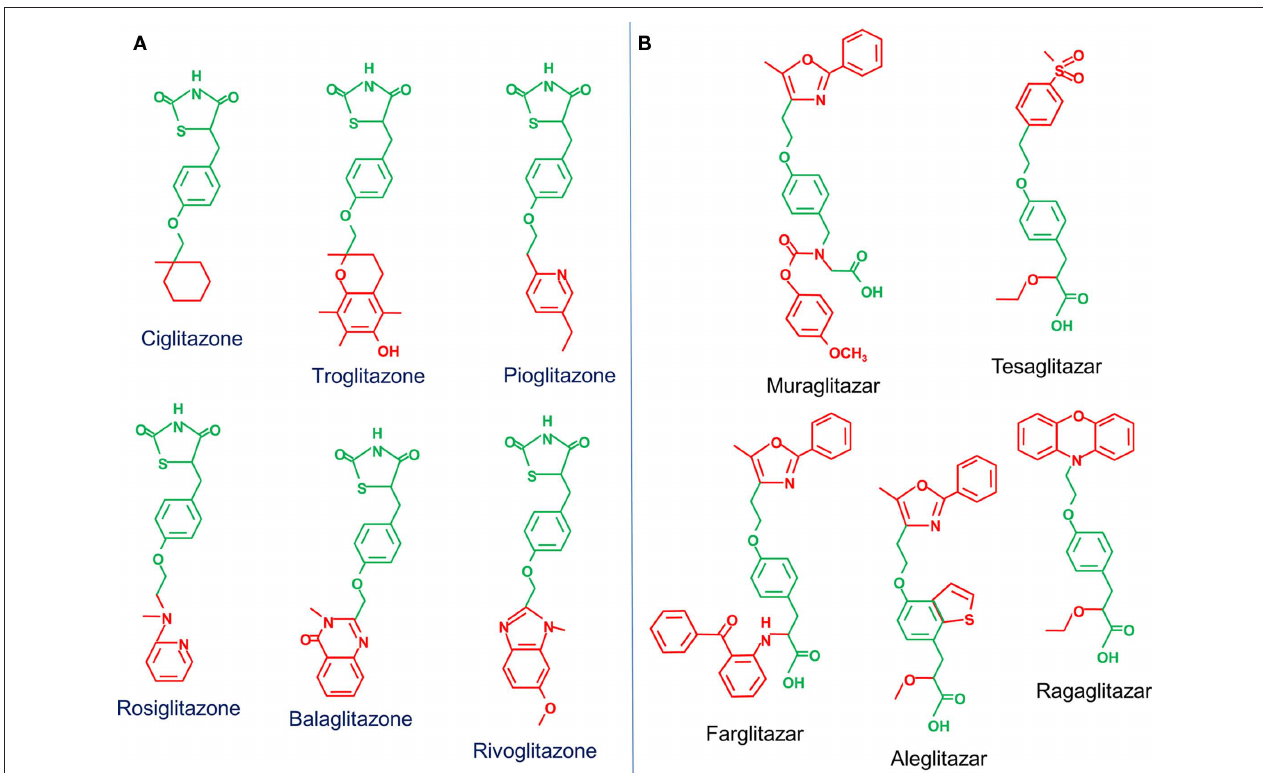
Figure 1 | Chemical structures of glitazones (A) and glitazars (B). The chemical structure shared by all the compounds of the class is indicated in green, while in red is the part of the molecule that characterizes individual compounds.